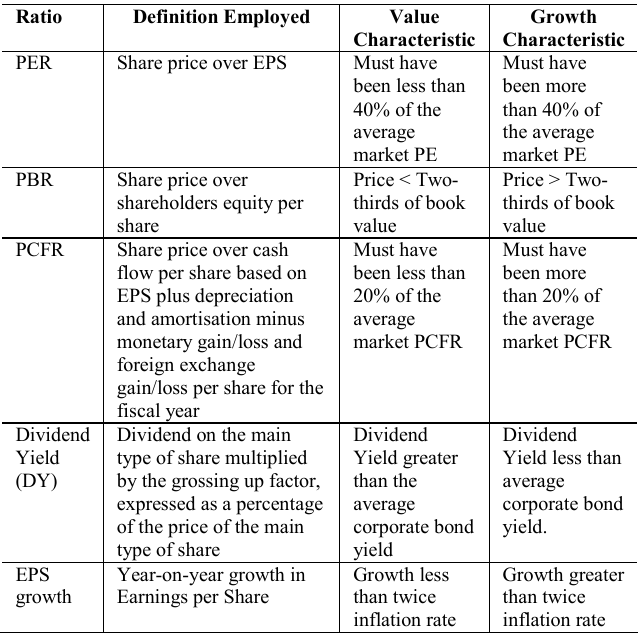
Table 2: How screen styles were